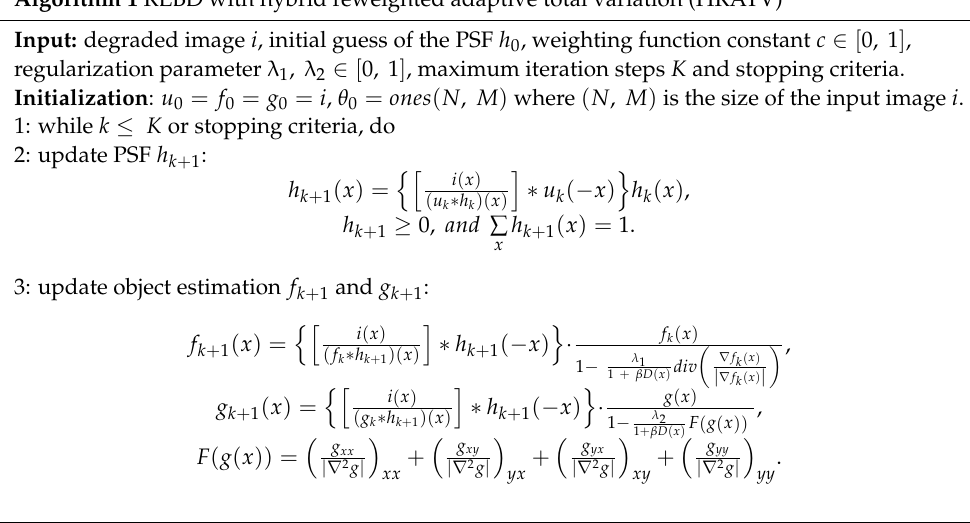
Algorithm 1 RLBD with hybrid reweighted adaptive total variation